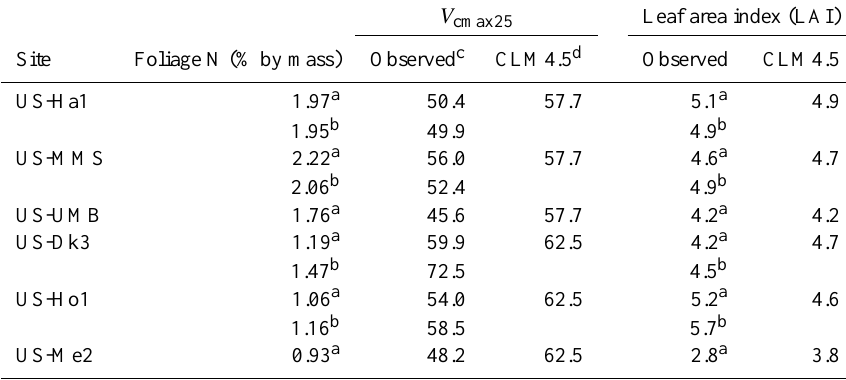
Table 5. Site vegetation parameters used in the model